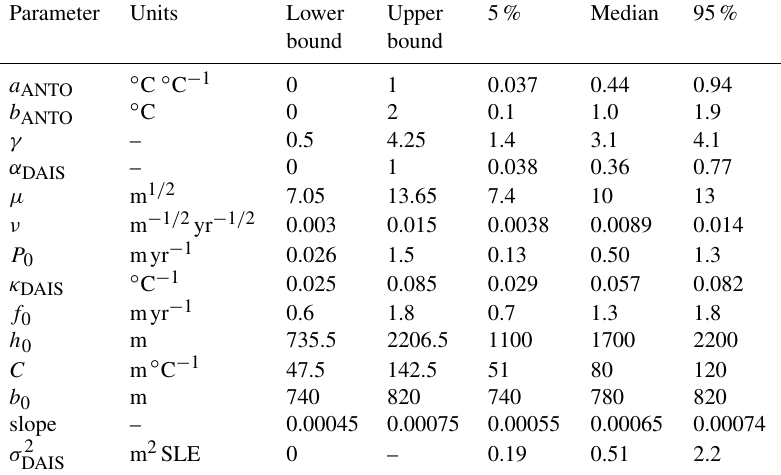
Table A4. Prior probability distribution ranges for the DAIS Antarc- tic Ice Sheet model parameters, and median, 5th, and 95th quan- tiles of the calibrated posterior parameter distributions. An in- verse gamma prior distribution is used for σ 2 et al., 2017). All other prior distributions are uniform.